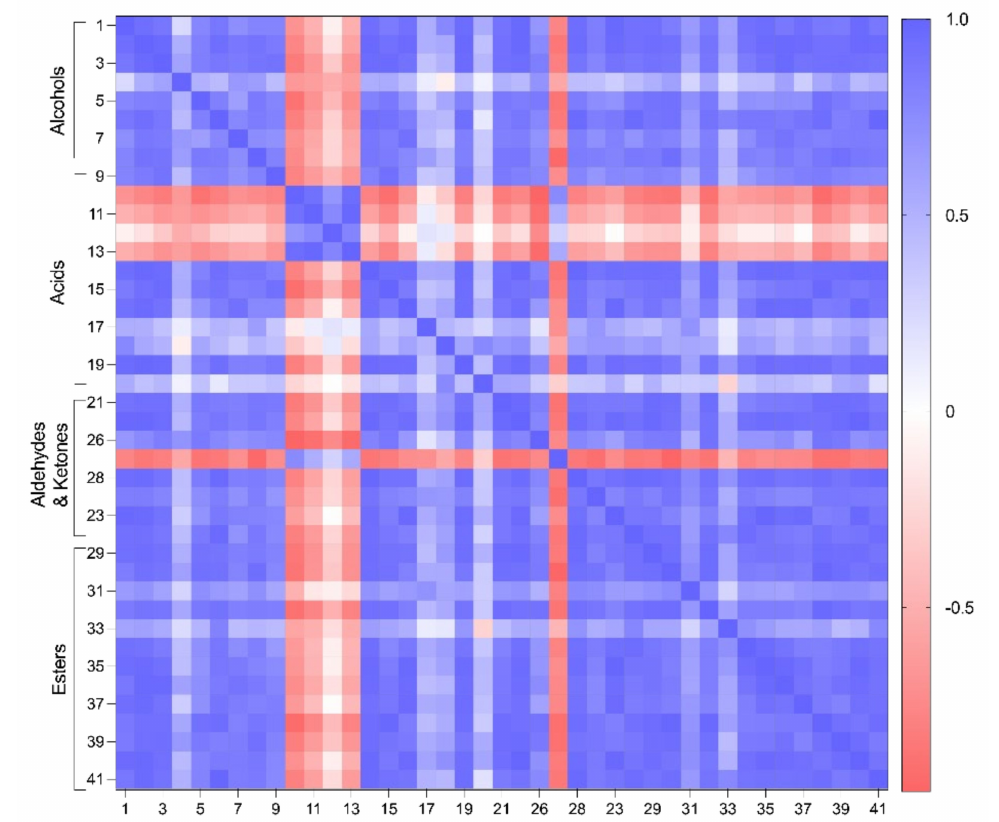
Figure 4. Heatmap of the correlation matrix of the volatile compounds ( p < 0.05). Numbers in loadings correspond to the volatile compounds identified in sourdoughs: 1–8 alcohols (Table 2); 9–20 acids (Table 3); 21–28 aldehydes and ketones (Table 4); and 29–41 esters (Table 5). Positive correlations are shown in blue; negative correlations in red; absence of correlation in